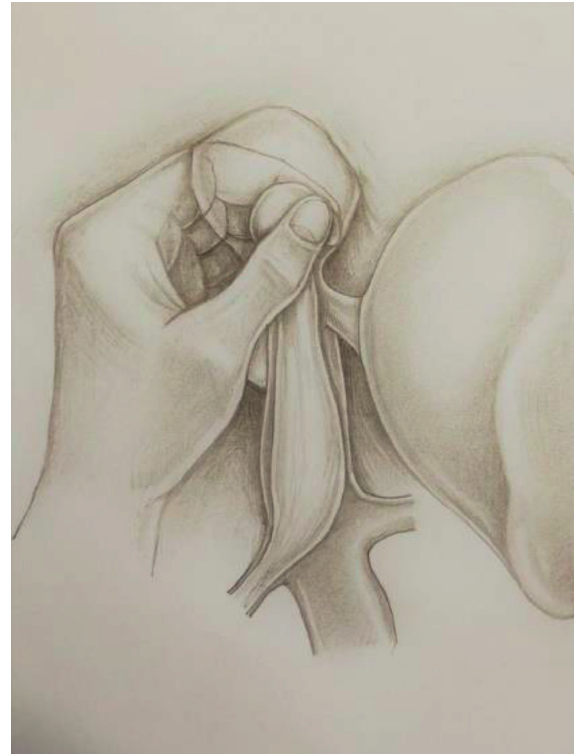
Figure 4: Performing “milking maneuver” in a patient with a large atrial tumor thrombus through the transpericardial access from the abdominal